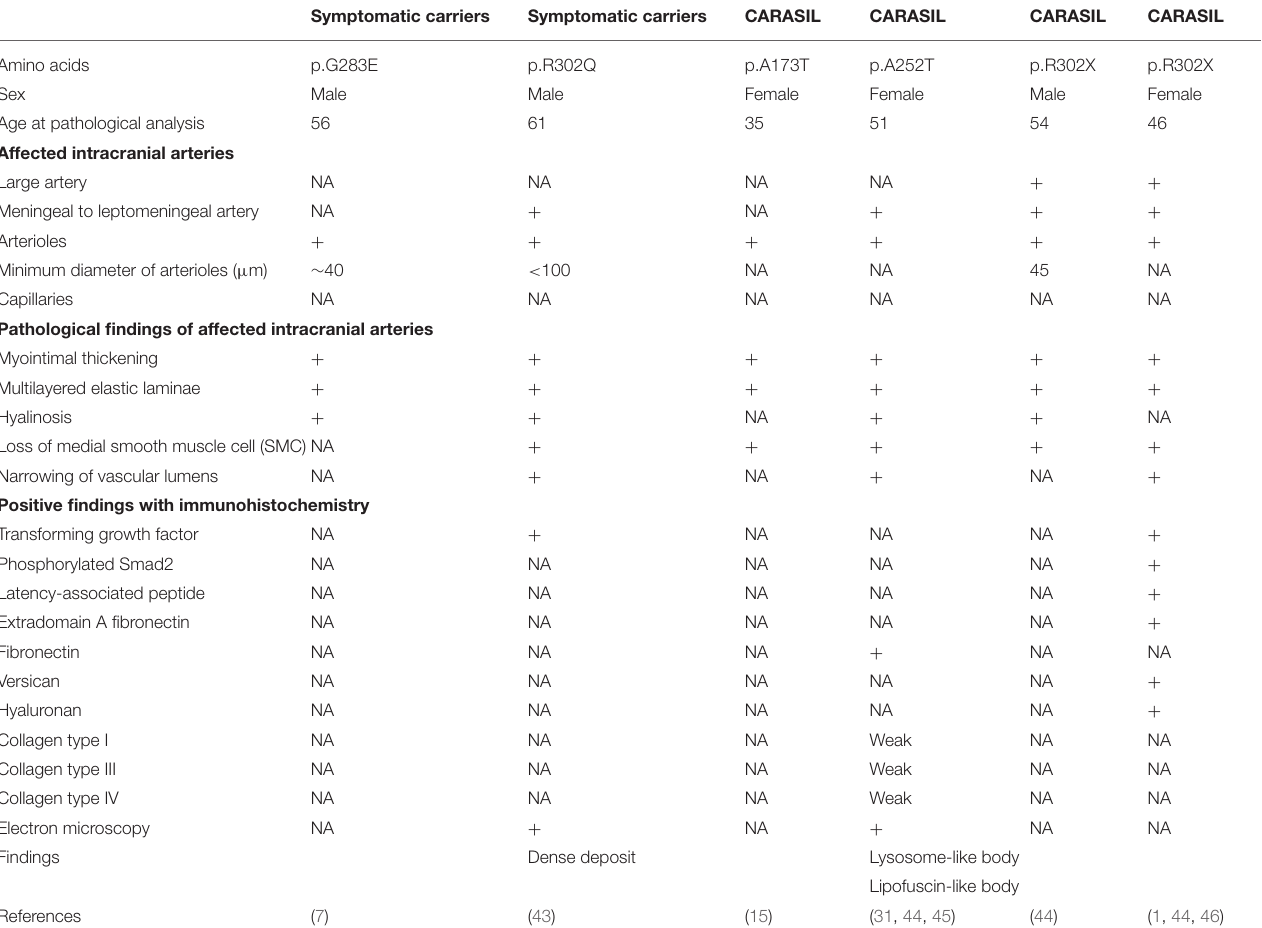
TABLE 4 | Summary of pathological findings in HTRA1 -related cerebral small vessel disease